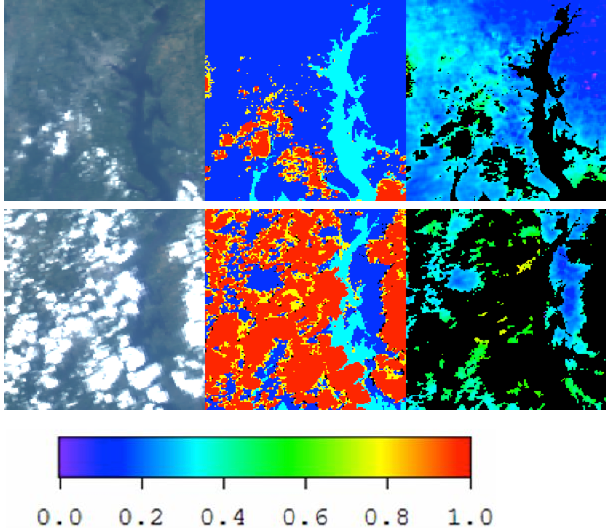
Figure 14. Similar to Fig. 12, but for MODIS sensor images from 15 July 2013, Terra satellite (top) at 15:30UTC and Aqua satellite (bottom) at